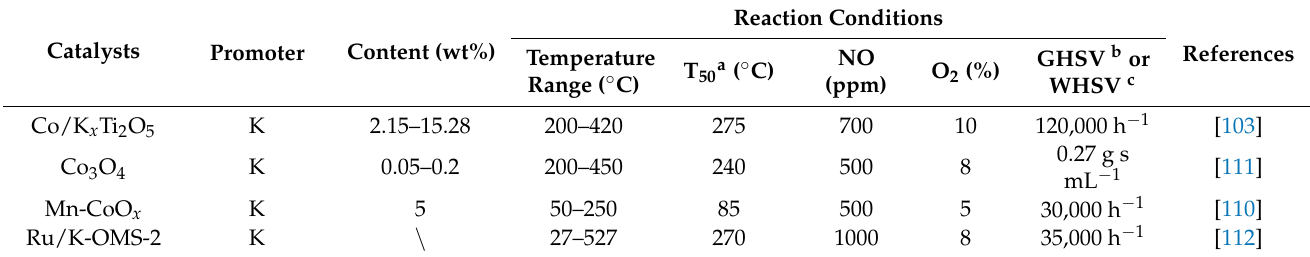
Table 5. Summary of catalysts and reaction conditions for NO oxidation promoted by alkali metals.